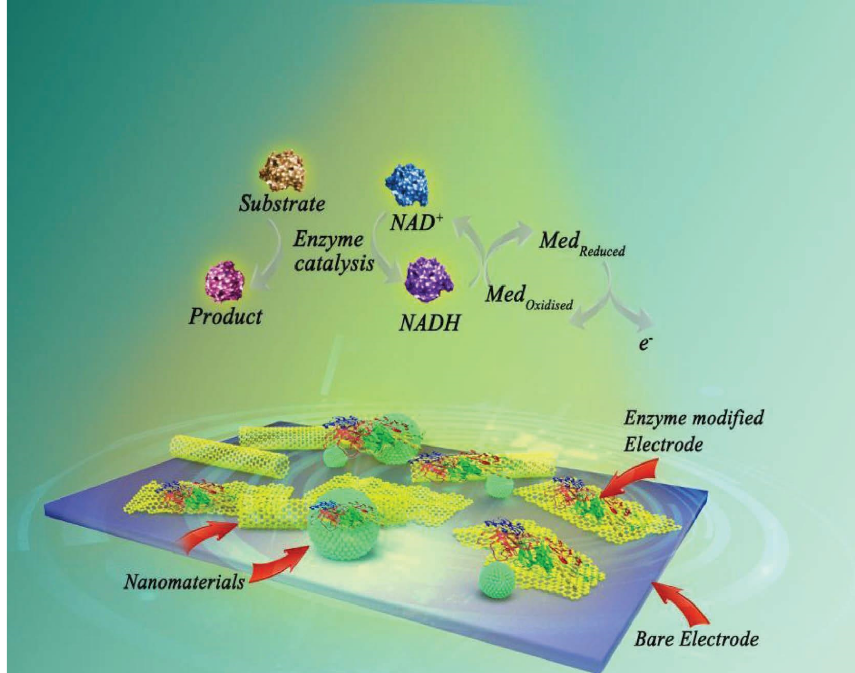
Figure 4: Electrochemical reactions involved in NAD + /NADH-dependent electrochemical dehydrogenases biosensors operating with